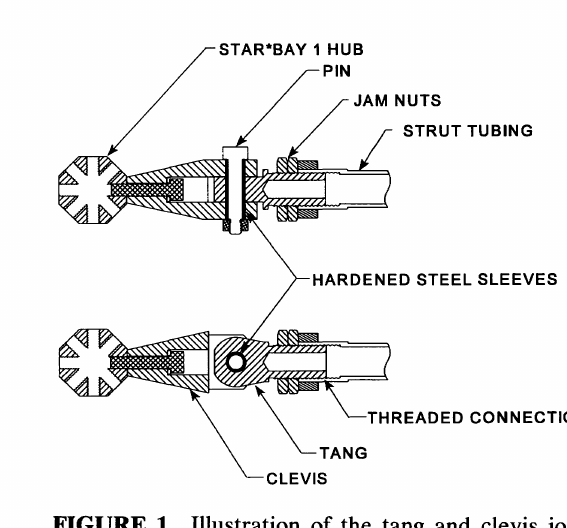
FIGURE 1 Illustration of the tang and clevis joint